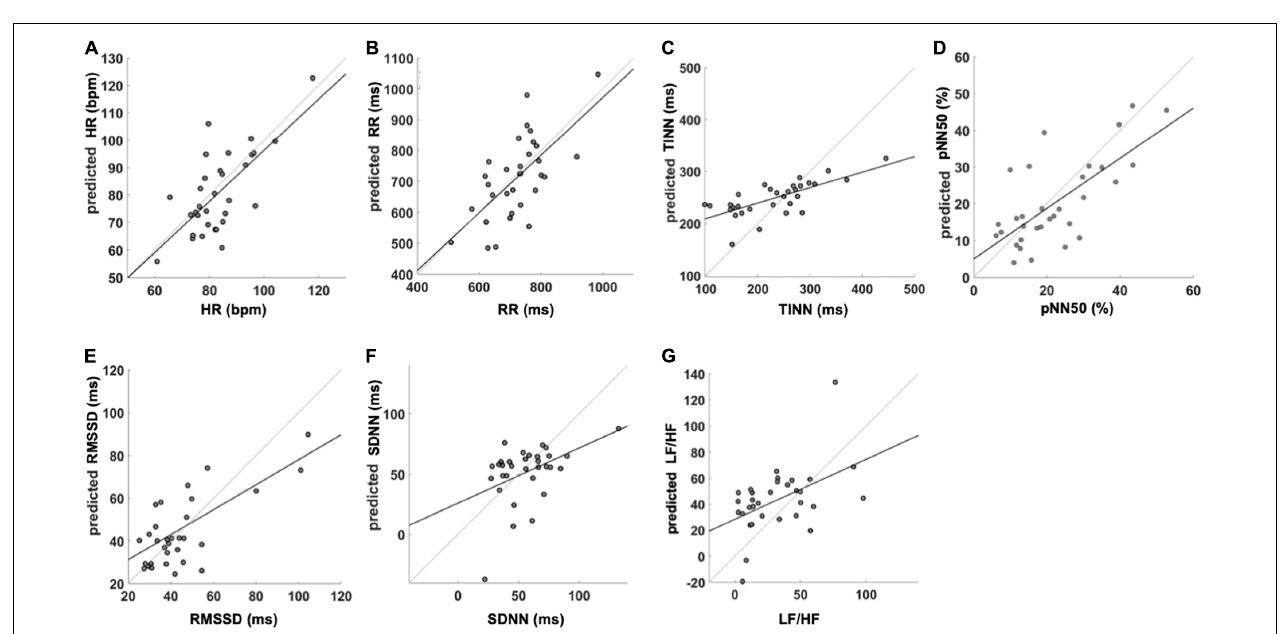
FIGURE 3 | The weights for each predictor used in the support vector regressor (SVR) models to estimate (A) HR, (B) RR, (C) TINN, (D) pNN50 (%), (E) RMSSD, (F) SDNN, and (G) LF/HF are shown. N, nostrils; NT, nose tip; G, glabella.